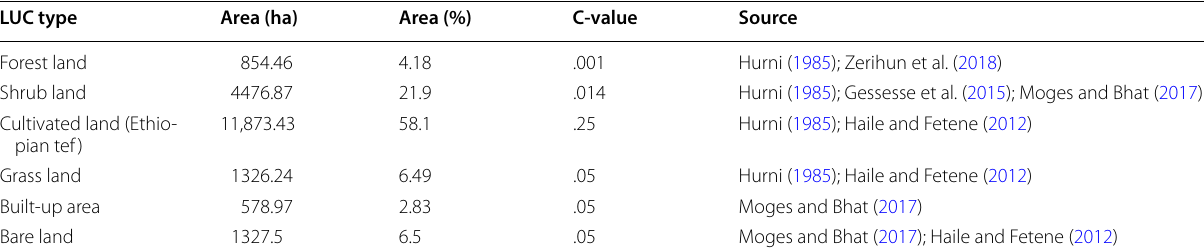
Table 5 Land use/cover, area coverage and published C-values